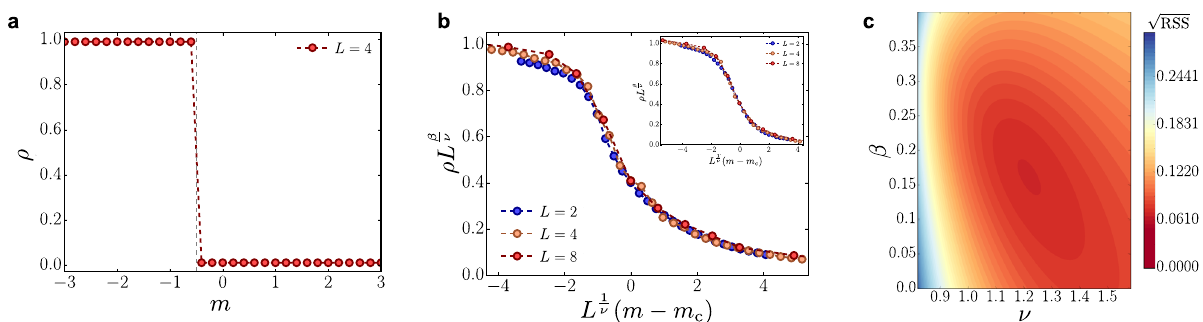
¼ 0 and L = 4. b Universal scaling function λ ( x ) close to the transition Fig. 9 Finite-size scaling analysis. a Particle density as a function of m , for t = 0, g 2 m point m c ≈ − 0.39 for g 2 ¼ 0 with critical exponents β ≈ 0.16 and ν ≈ 1.22. The inset shows the same universal behavior close to the transition point m c m ≈ 0.22 in the presence of magnetic interactions with g 2 ¼ 8 = g 2 ¼ 4 and the same critical exponents β ≈ 0.16 and ν ≈ 1.22. c Contour plot of the square root m e of the residual sum of squares in the ( ν , β ) plane for the best- fi tting values of the critical